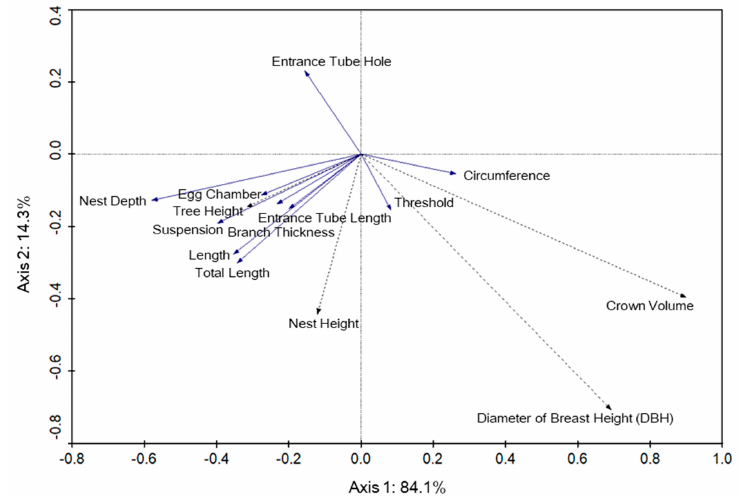
Figure 4. Baya weaver ( Ploceus philippinus ) nest humidity (% RH) and atmospheric humidity (%RH) across 34 nests in Selangor and 32 nests in Perlis, Malaysia. The redundancy analysis using nest structure and nest tree variables indicated that in Selangor, nest structure was not significantly correlated with nest tree variable. The first and second axes explained 84.1% and 14.3% of the variance respectively, in the model (Figure 5). Species–environment correlations were 0.327 for axis 1 and 0.239 for axis 2. Species in this analysis is a reference to baya weaver nests, while environment re- fers to tree characteristics. The height of the nest (F = 0.14, p = 0.812) showed a positive association with total vertical length and the suspension of the nest, although it was not significant.